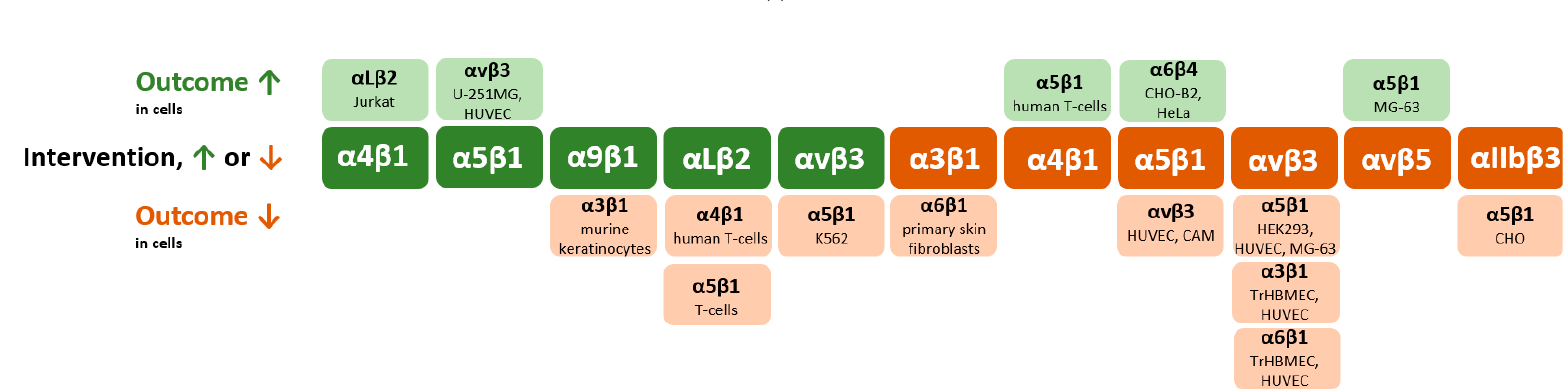
Figure 3. Integrin crosstalk examples documented in experiments that interfere with ( a ) α or ( b ) β integrin subunit or ( c ) integrin heterodimer, listed in Table 1. ↑ denotes upregulation of integrin expression or activation, while ↓ denotes integrin downregulation or inhibition.